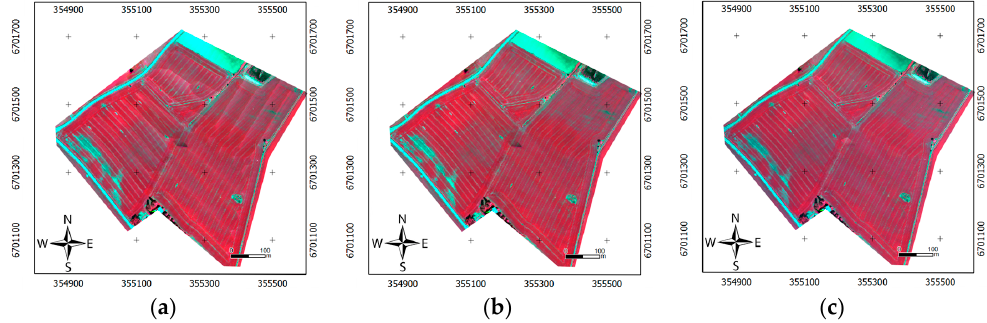
Figure 7. Color infrared mosaics of the entire flight area with green (L0 = 549.6 nm), red (L0 = 663.8 nm) and NIR (L0 = 794.0 nm) bands. Radiometric model: ( a ) Reflectance transformation using empirical line method; ( b ) reflectance transformation using empirical line method and BRDF-correction, and ( c ) full radiometric block adjustment with absolute calibration and relative image-wise corrections and BRDF correction.